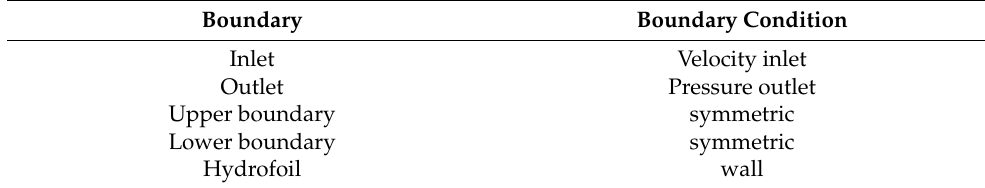
Table 1. Boundary types of computational